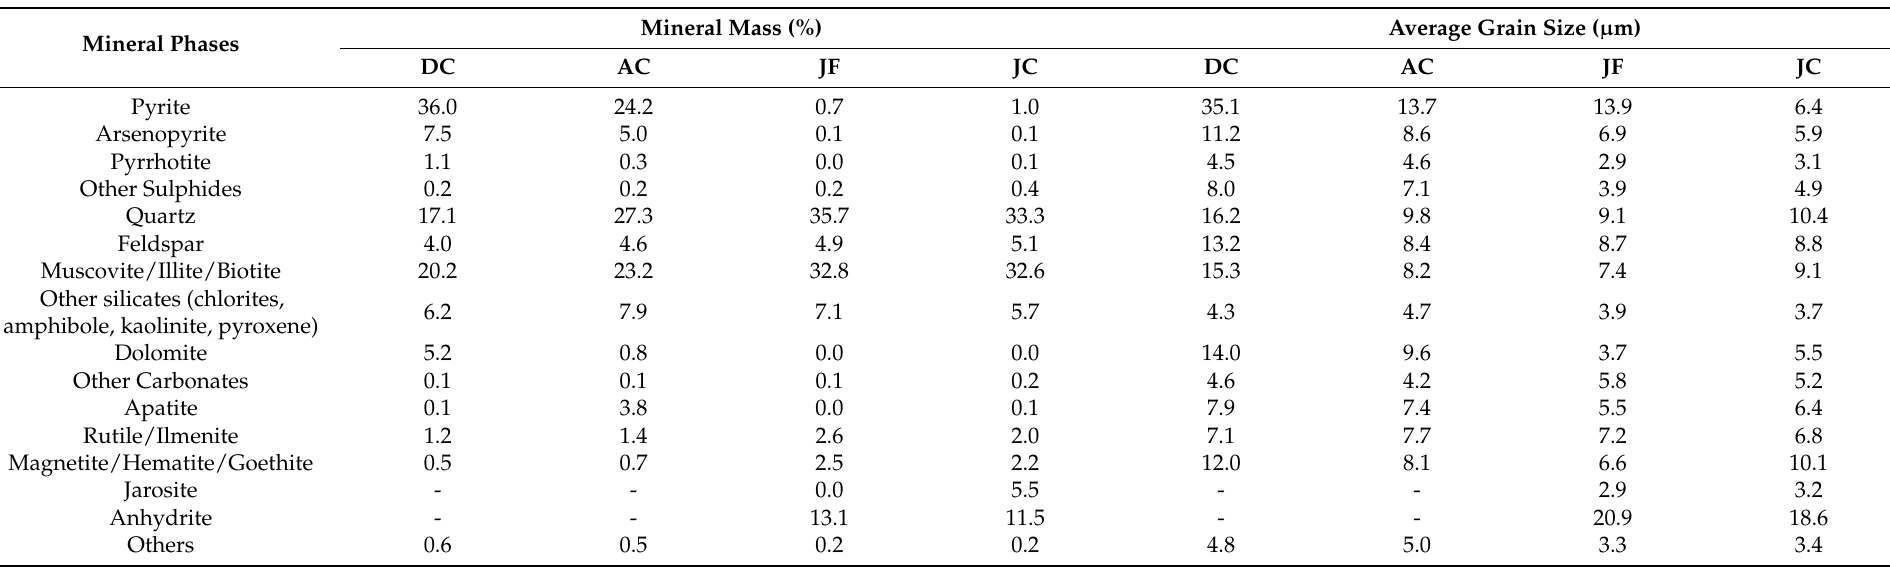
Table 1. Mineral mass (%) and average grain size ( µ m) of studied flotation and bio-oxidation products using QEMSCAN. Modified after Asamoah et al, 2019 [1]. DC—Dolomite